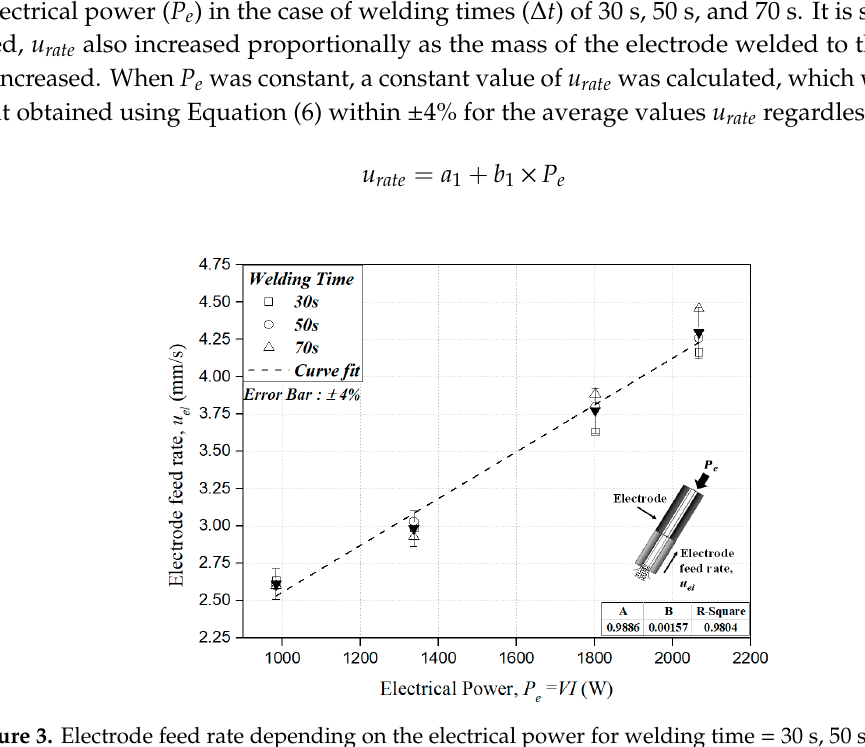
Figure 3. Electrode feed rate depending on the electrical power for welding time = 30 s, 50 s, and 70 s. Here, a 1 and b 1 are experimental